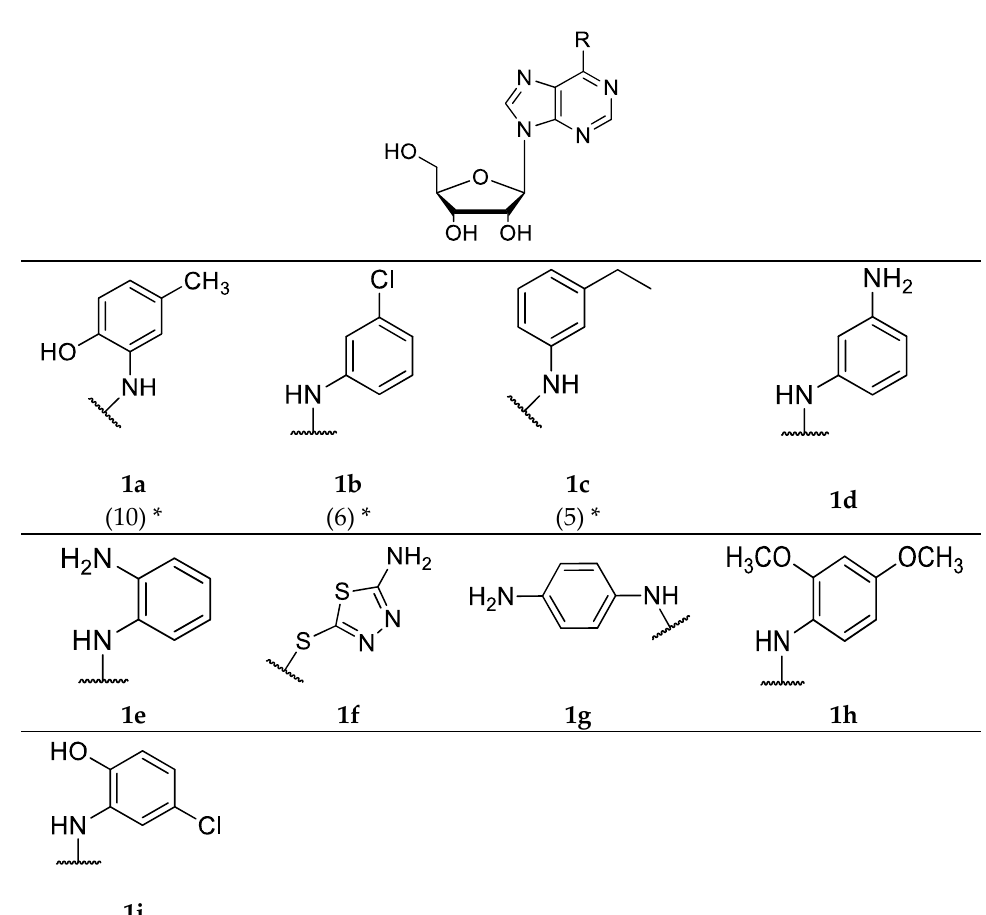
Figure 4. Structures of adenosine derivatives that belong to the series 1. (* Compounds suggested by molecular docking).